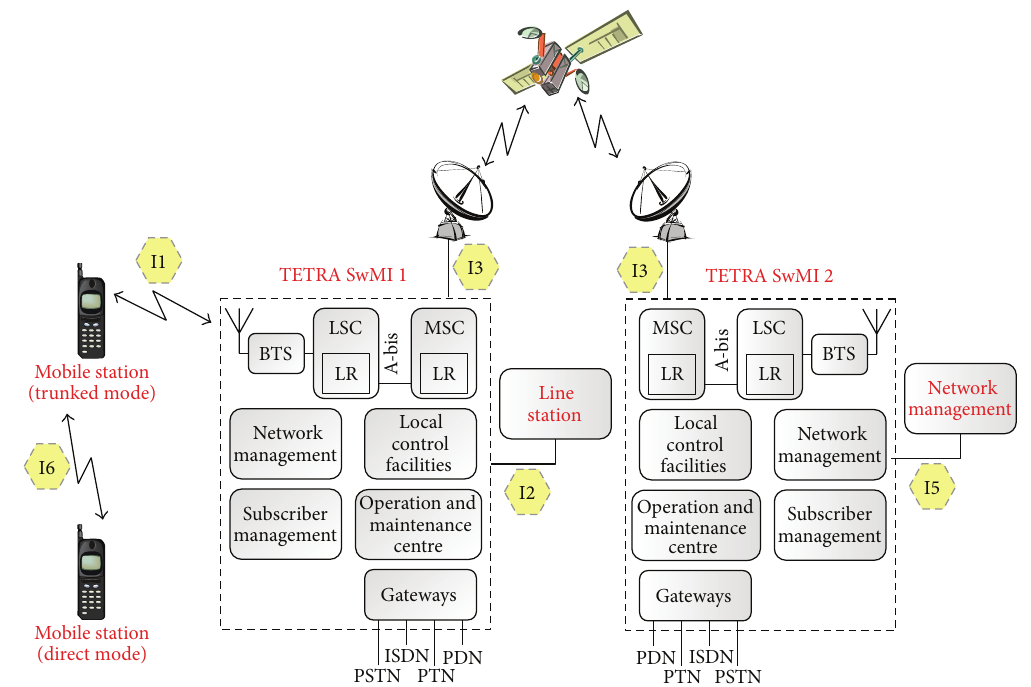
Figure 2: ISI-based TETRA backhauling via